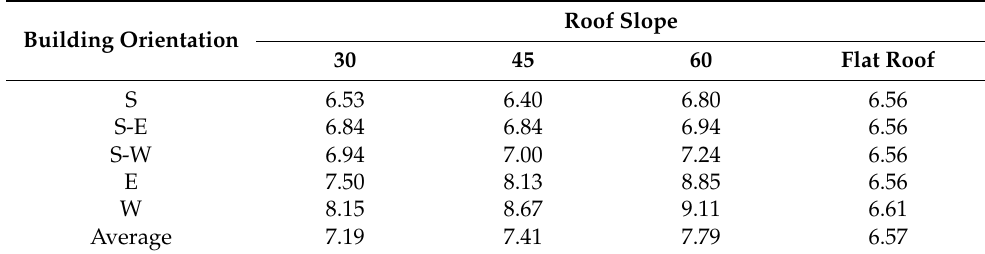
Table 5. The mean Discounted Payback Period on a macroeconomic level, depending on the orienta- tion and inclination angle of the roof